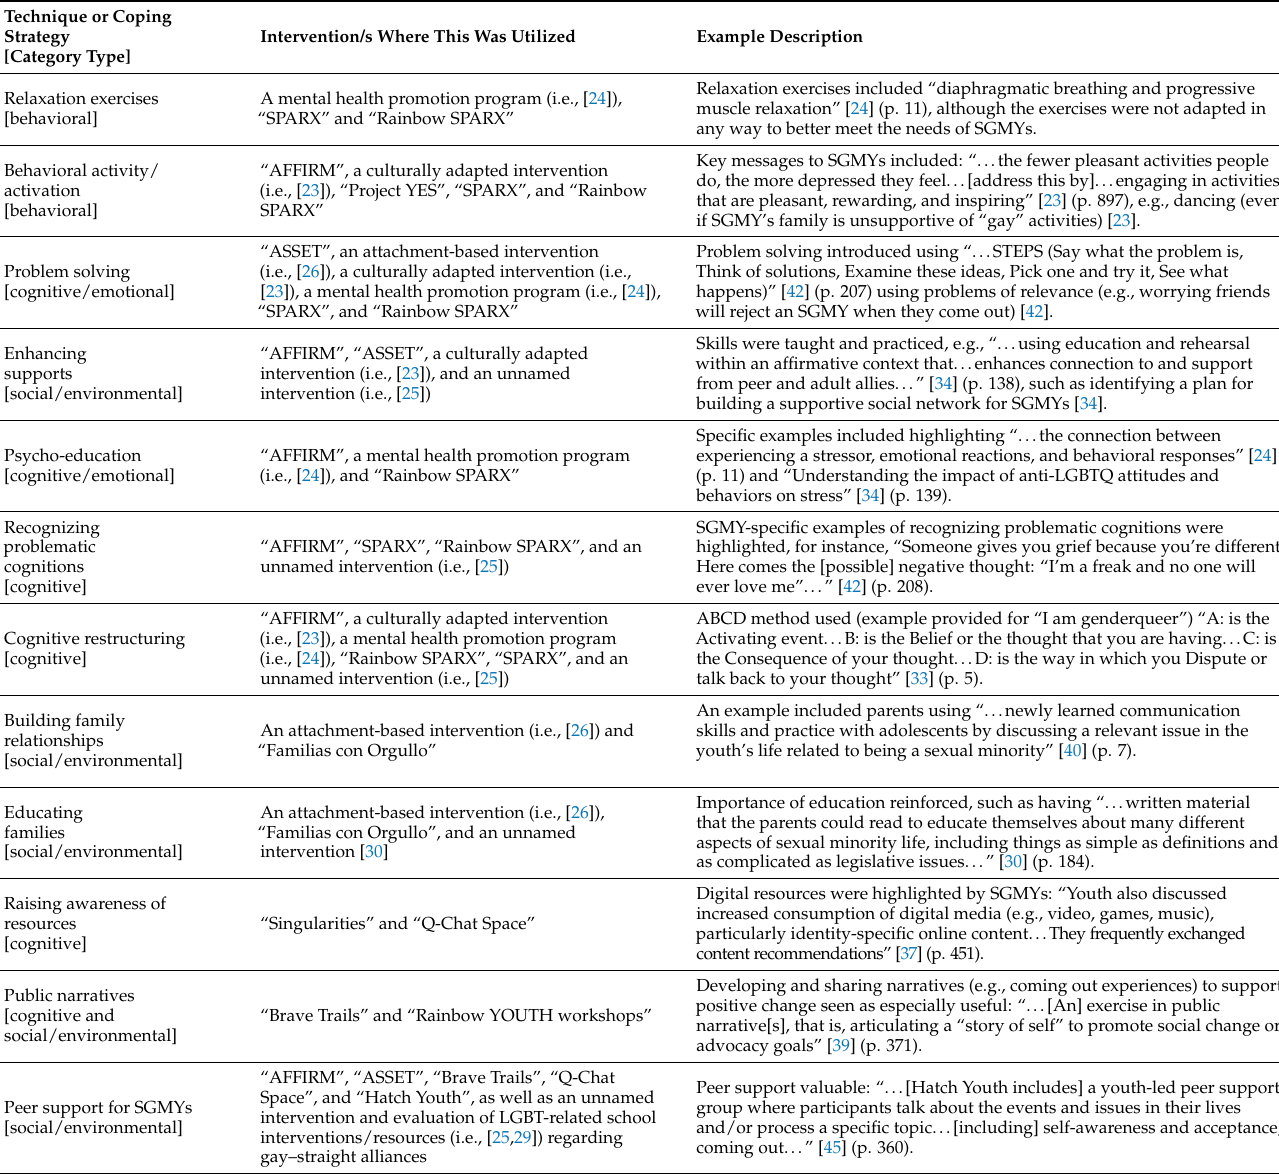
Table 2. Common content across the intervention-focused